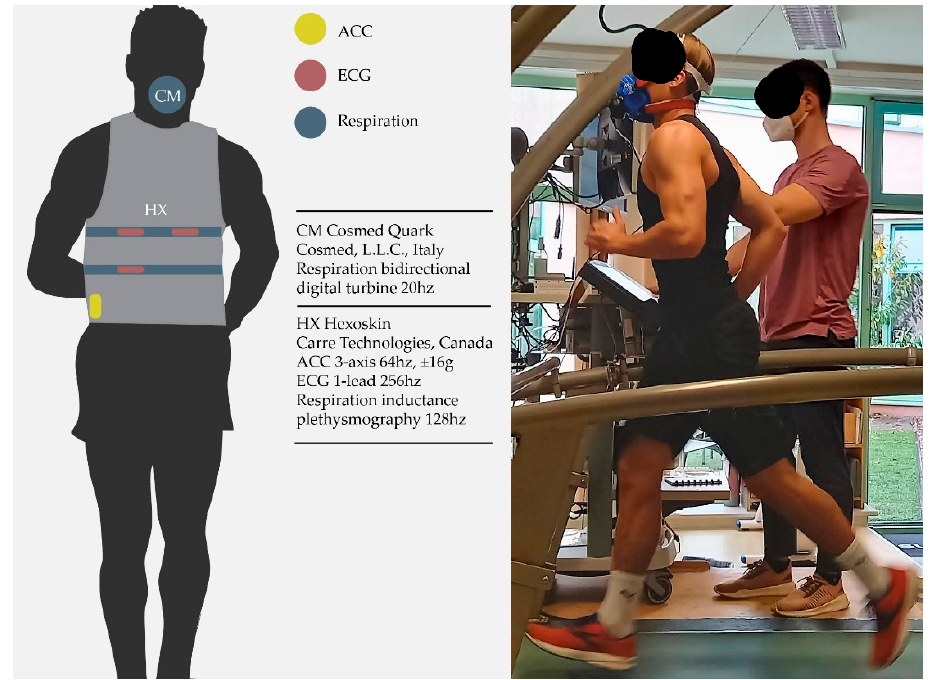
Figure 1. Experimental sensor setup with reference spirometer setup and Hexoskin smart shirt. ACC: accelerometer, ECG: electrocardiogram, CM: Cosmed, HX: Hexoskin. accelerometer, ECG: electrocardiogram, CM: Cosmed, HX: